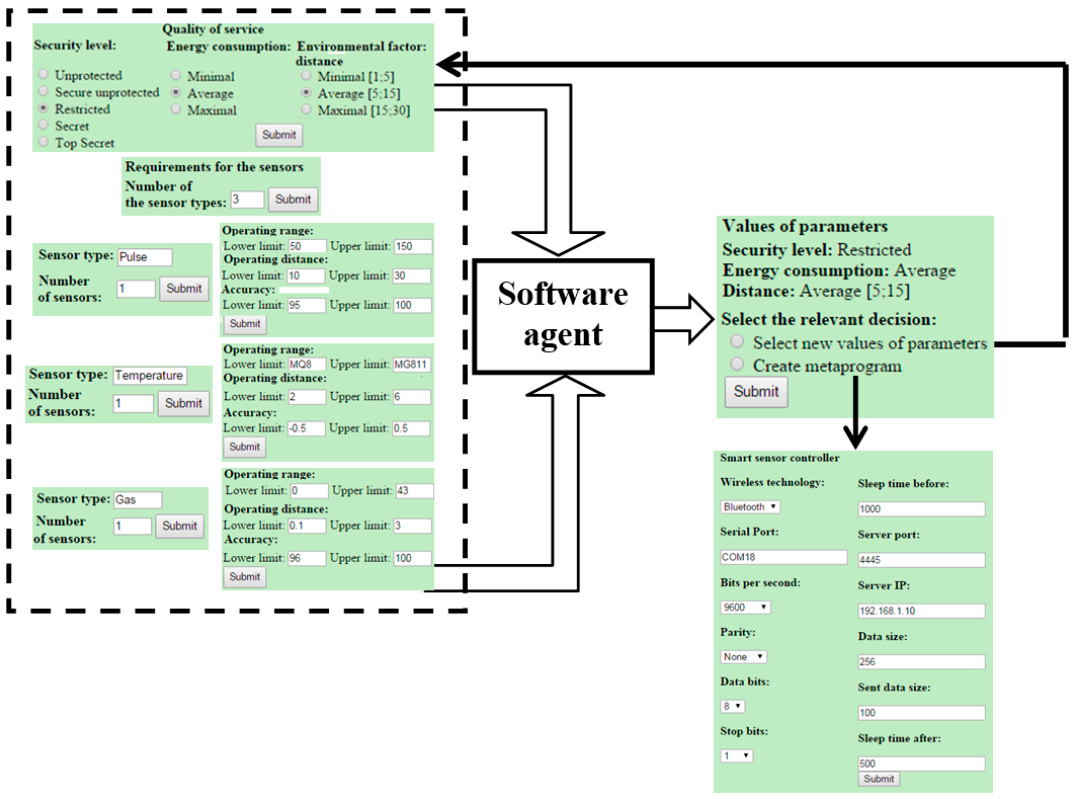
Figure 9. Structure of the two-level meta-program interface.